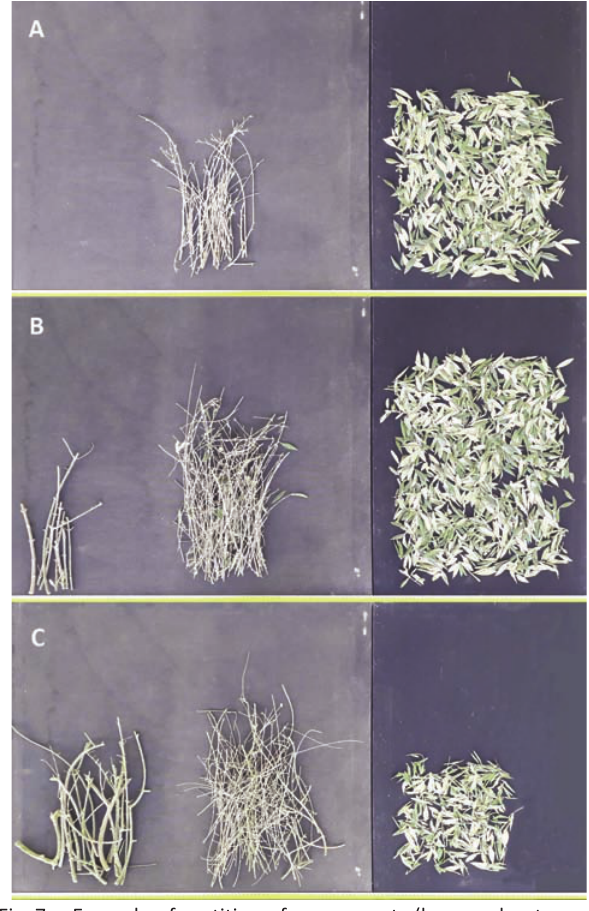
Fig. 7 - Example of partition of components (leaves, shoots, and branches) of the canopy transversal sections in a olive tree of cv. Arbequina (Tombolo farm, 2018) measured in a sampling units (1 unit = 1 m 2 ), side West. A) Outer sec- tion (15 cm); B) Intermediate section (25 cm); C) Inner section (40 cm from the main tree